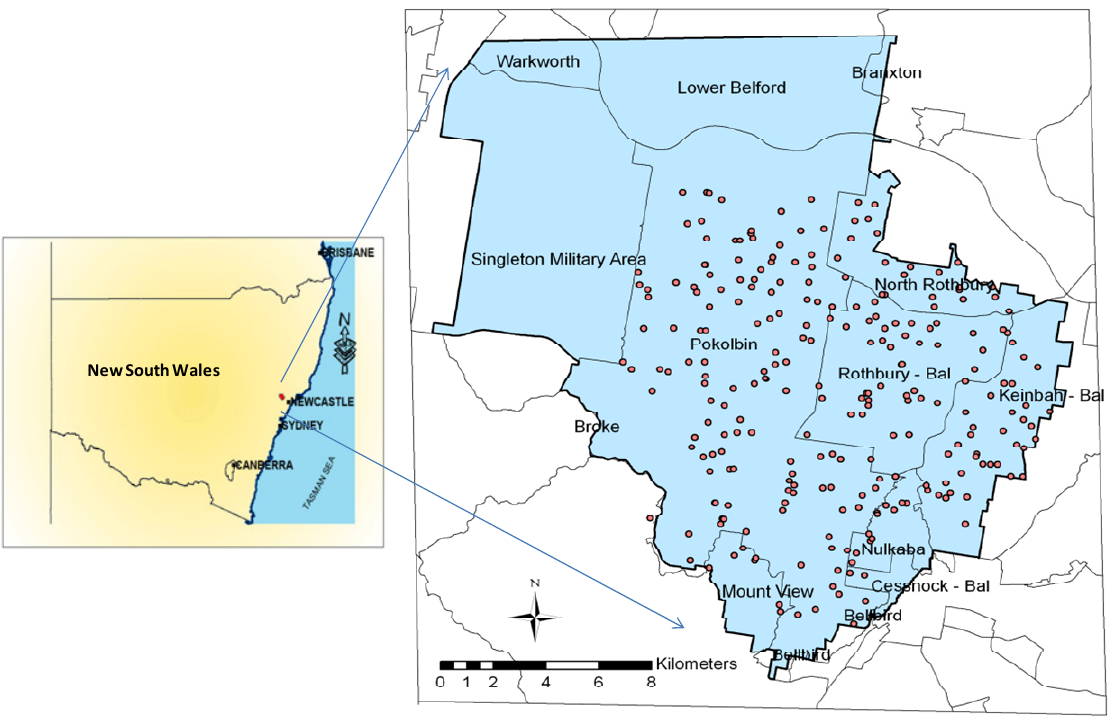
Figure 1. Location of the study area in New South Wales, Australia, showing soil sample sites as red dots. Note: the thin grey lines are the suburb